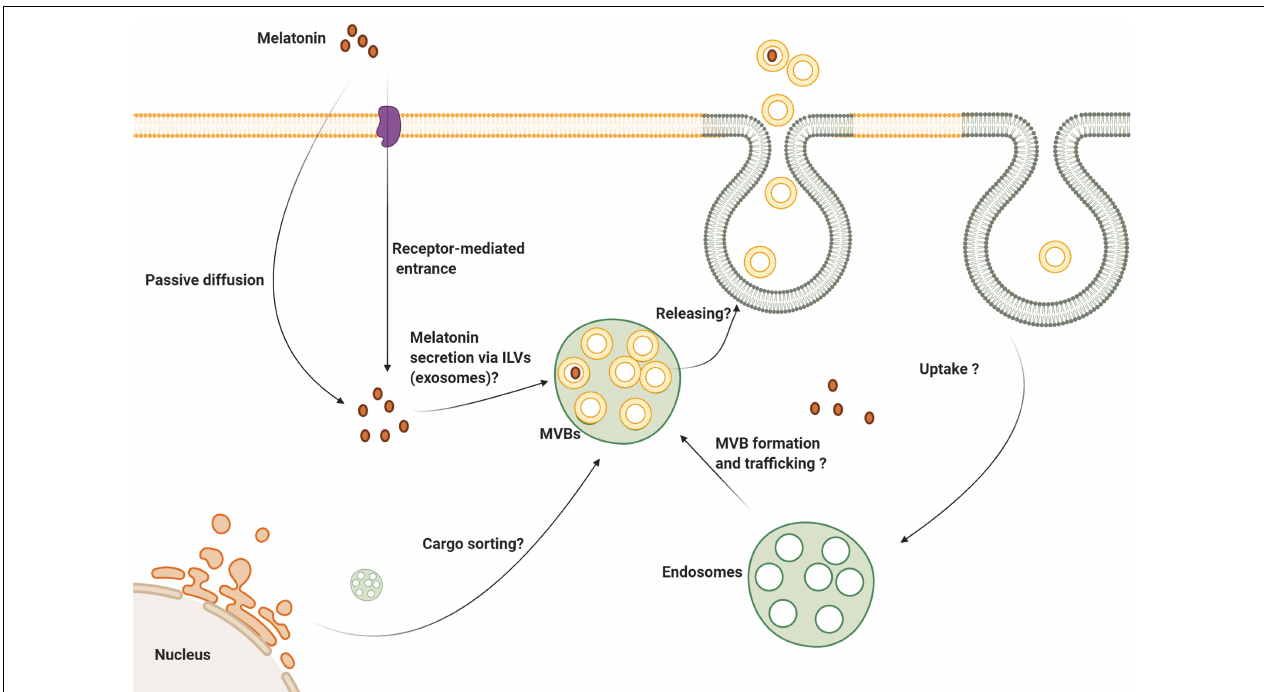
FIGURE 4 | Several aspects of melatonin’s effect on exosome biogenesis and secretion are still unknown. Melatonin can enter the cells via membrane-bound receptors and passive diffusion. It is logical to state that melatonin can be secret via the exosomes to the extracellular niche. Whether melatonin directly or indirectly influences exosome biogenesis, trafficking and abscission need further